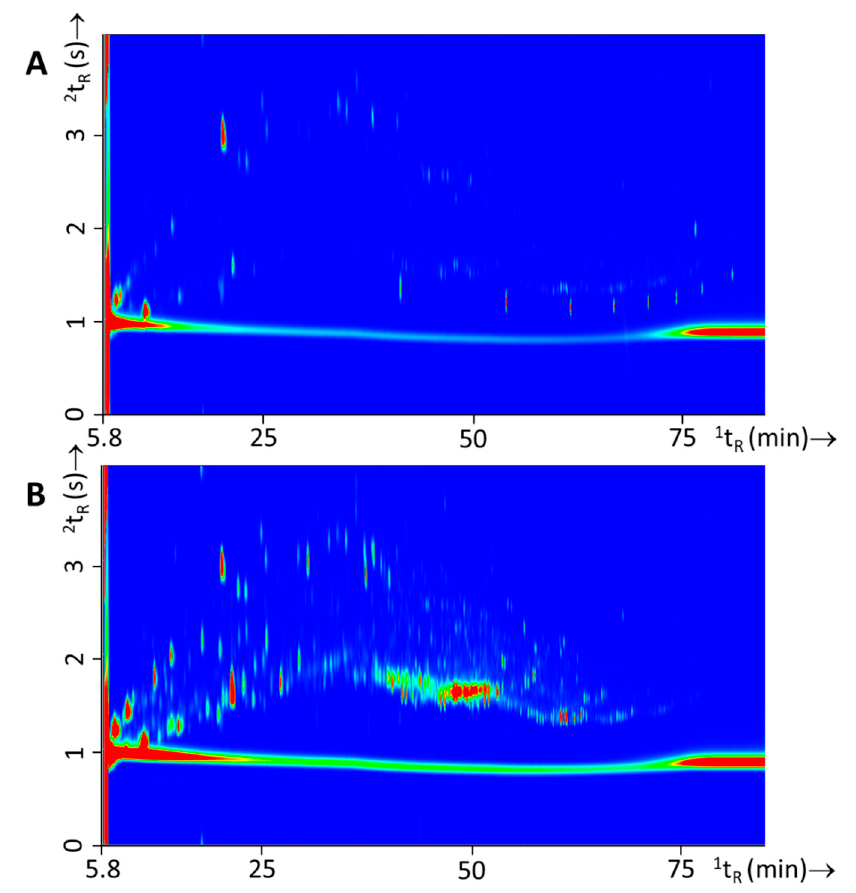
Figure 10. GC×GC-TOFMS TIC contour plot of ( A ) experiment 82 and ( B ) experiment 84. Figure 10. GC × GC-TOFMS TIC contour plot of ( A ) experiment 82 and ( B ) experiment